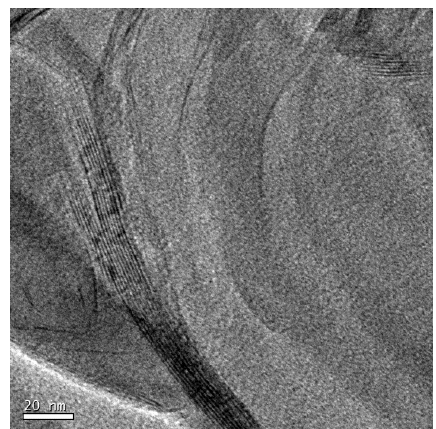
Figure 10. TEM micrograph at high magnification for sample with 5 wt% clay prepared by ·MEA and cured isothermally at 180 cationic initiation with 1% BF 3